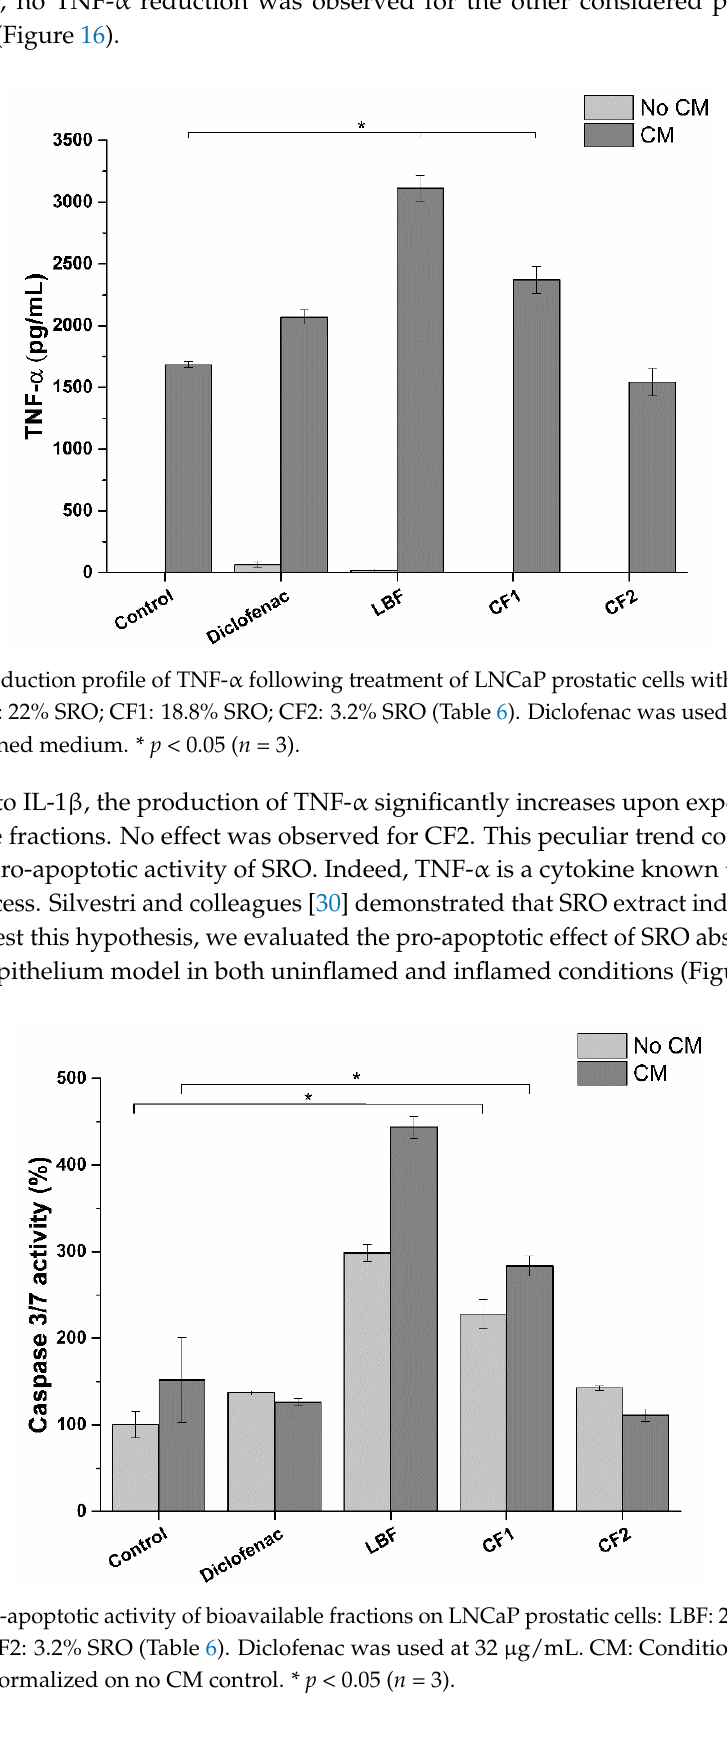
Figure 15. Production profile of IL-1β following treatment of LNCaP prostatic cells with bioavailable fractions: LBF: 22% SRO; CF1: 18.8% SRO; CF2: 3.2% SRO (Table 6). Diclofenac was used at 32 µg/mL. CM: Conditioned medium. * p < 0.05 ( n = 3).